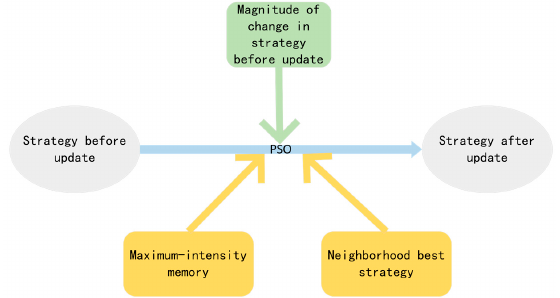
Figure 1. The conceptual graph of the model under study. The algorithm pseudo-code and flowchart regarding the above model are given by Algorithm 1 and Figure 3,